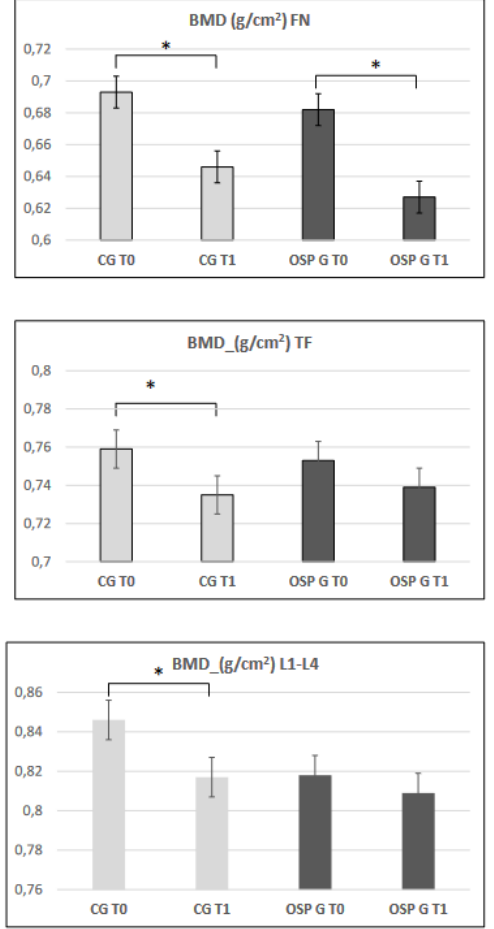
Figure 1. BMD values in FN, TF, and L1 – L4 in the two studied groups, namely CG and OSPG. * indicates a statistically significant difference between the variables * indicates a statistically significant difference between the